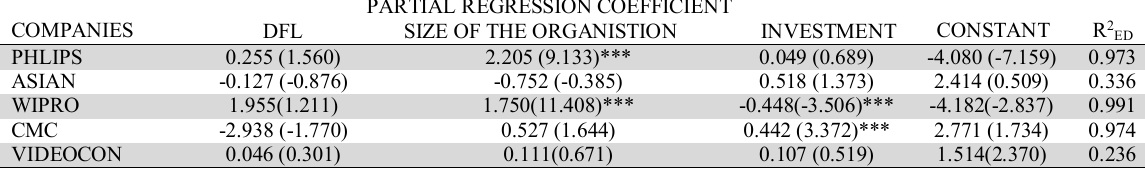
Statement Showing Multiple Regression of Avg Cash Holding on DFL, Size of Org. and Investment of the Selected Companies of IT